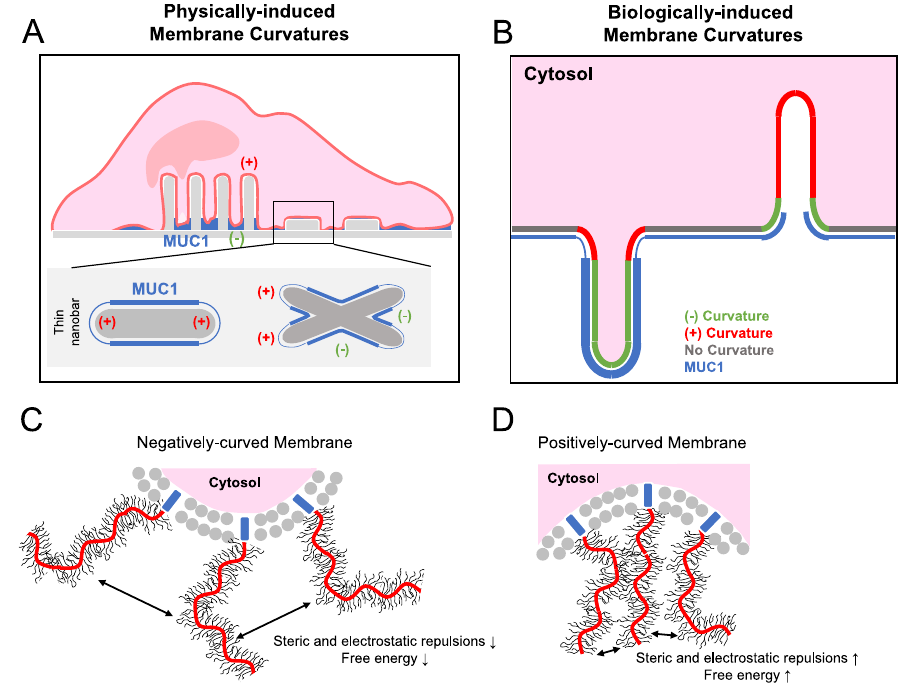
Fig. 8 Proposed models of how bulky glycoproteins respond to membrane curvature. A On vertical nanostructures, MUC1 shows a preference for negatively-curved and fl at membranes over positively-curved ones. B MUC1 prefers IRSp53-induced negatively-curved membranes rather than FBP17- induced positive curvature. C Molecular repulsions and the free energy of bulky glycoproteins are minimized as the cell membrane accommodates a negative curvature. D Steric and electrostatic repulsions and the free energy are increased when the cell membrane adopts a positive